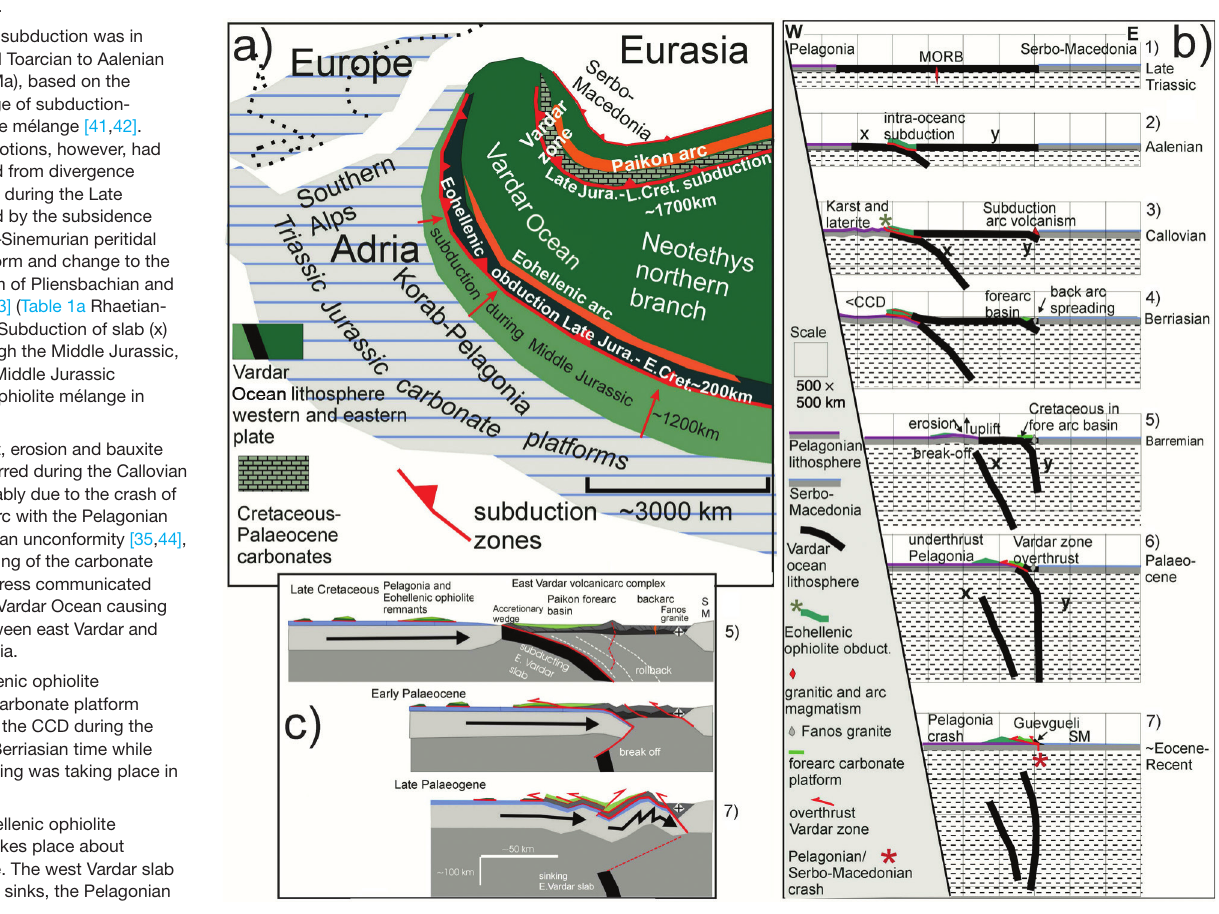
New Paleogeography